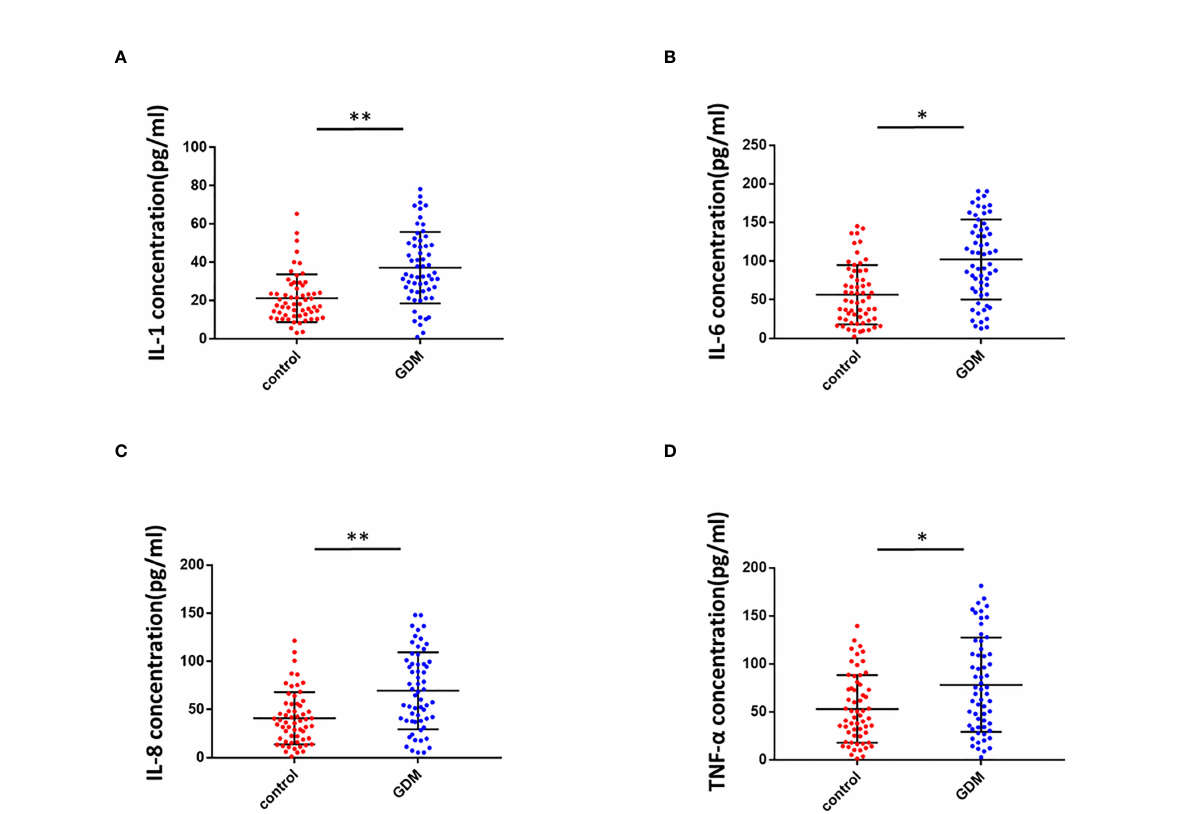
FIGURE 6 In fl ammation in the placental villous tissues of pregnant women with GMD. (A) IL-1 levels were signi fi cantly higher in the placental villous tissues of pregnant women with GMD (P < 0.01). (B) IL-6 levels were signi fi cantly higher in the placental villous tissues of pregnant women with GMD (P < 0.05). (C) IL-8 levels were signi fi cantly higher in the placental villous tissues of pregnant women with GMD (P < 0.01). (D) TNF- a levels were signi fi cantly higher in the placental villous tissues of pregnant women with GMD (P < 0.05). *P<0.05;